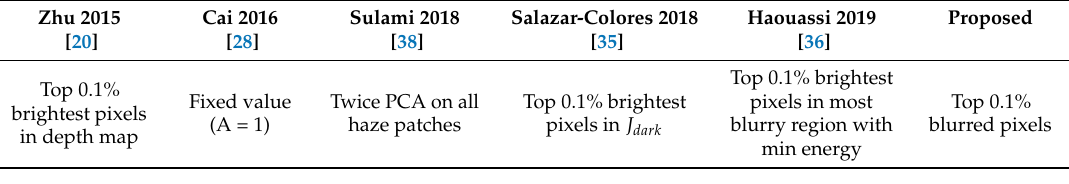
Figure 4. A practical example of proposed algorithm “A-Est”. The red spot indicates the region of interest (quadtree with maximum blur amount). The last row shows blur maps of each quadtree with the blur measure. Table 1. Summary of AL estimation methods used in existing and proposed dehazing approaches.